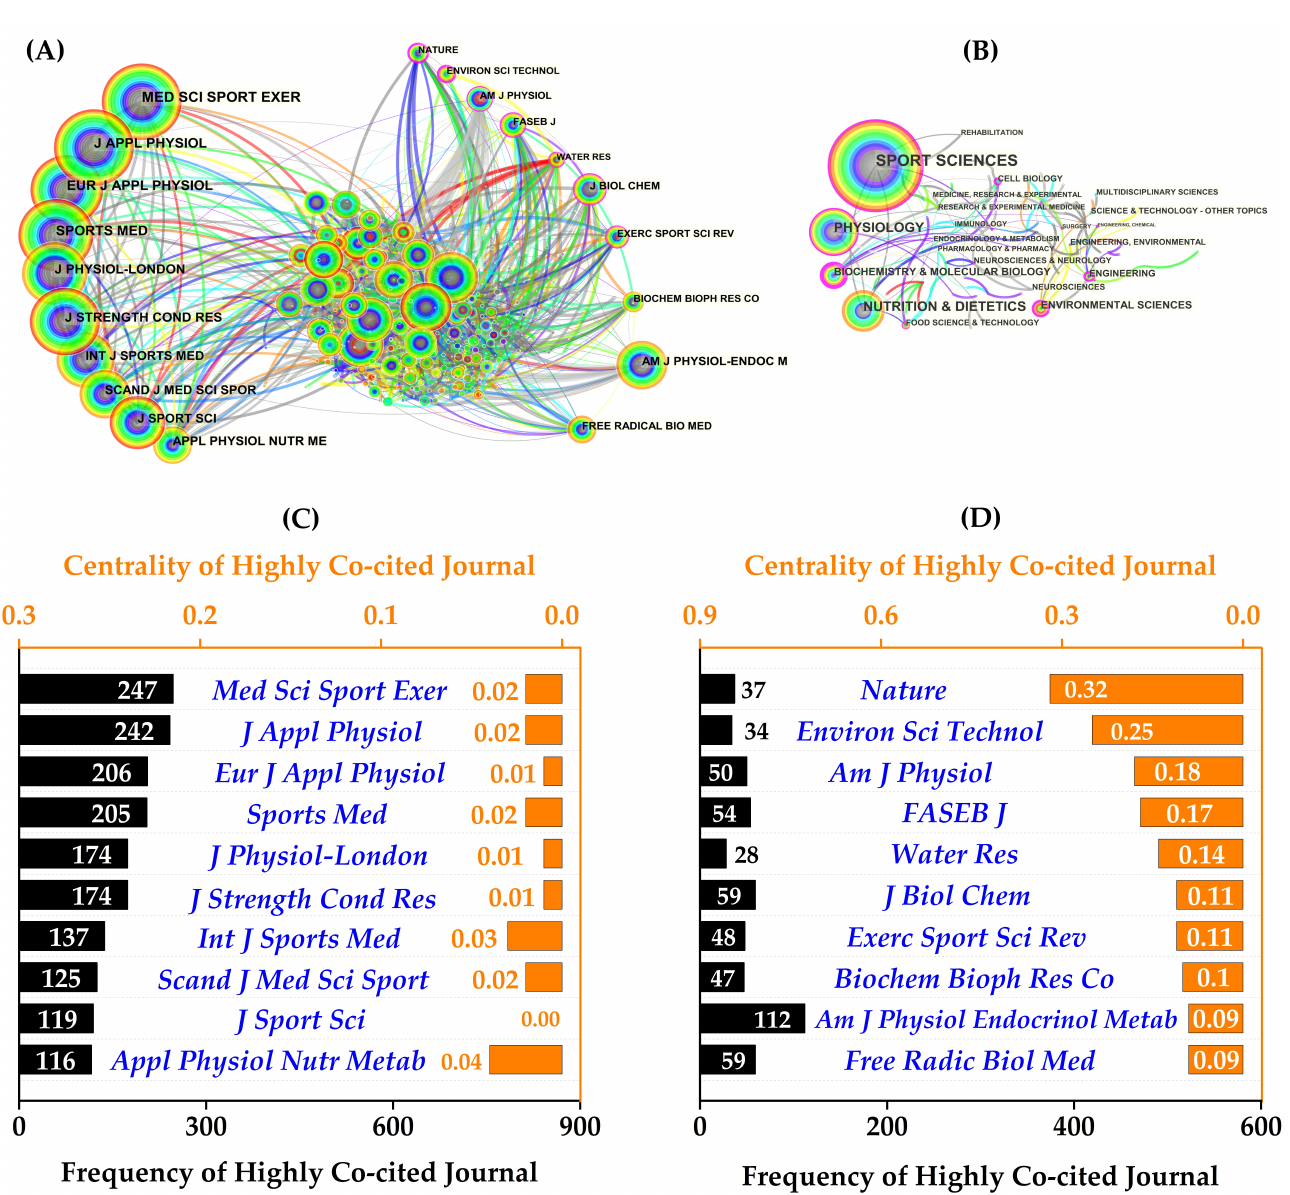
Figure 5. The visualization of the co-citation network and information on the top ten co-cited journals. ( A ) The network map of co-cited journal collaboration and ( B ) discipline categories; ( C ) the frequency and ( D ) centrality of publications in the top ten co-cited